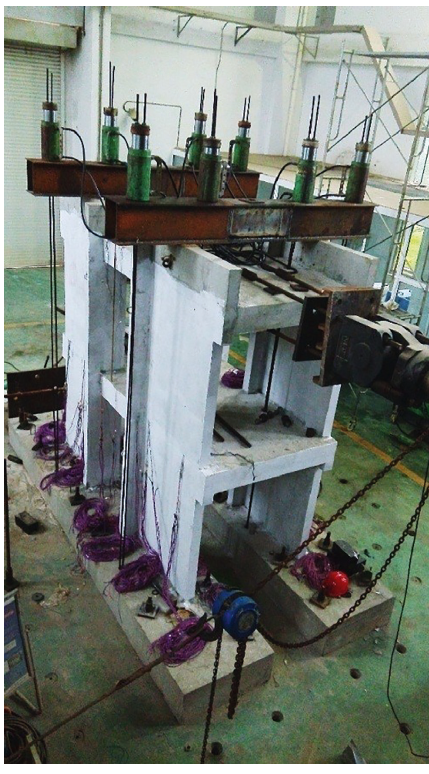
Figure 8: The test setup and specimen in reality.